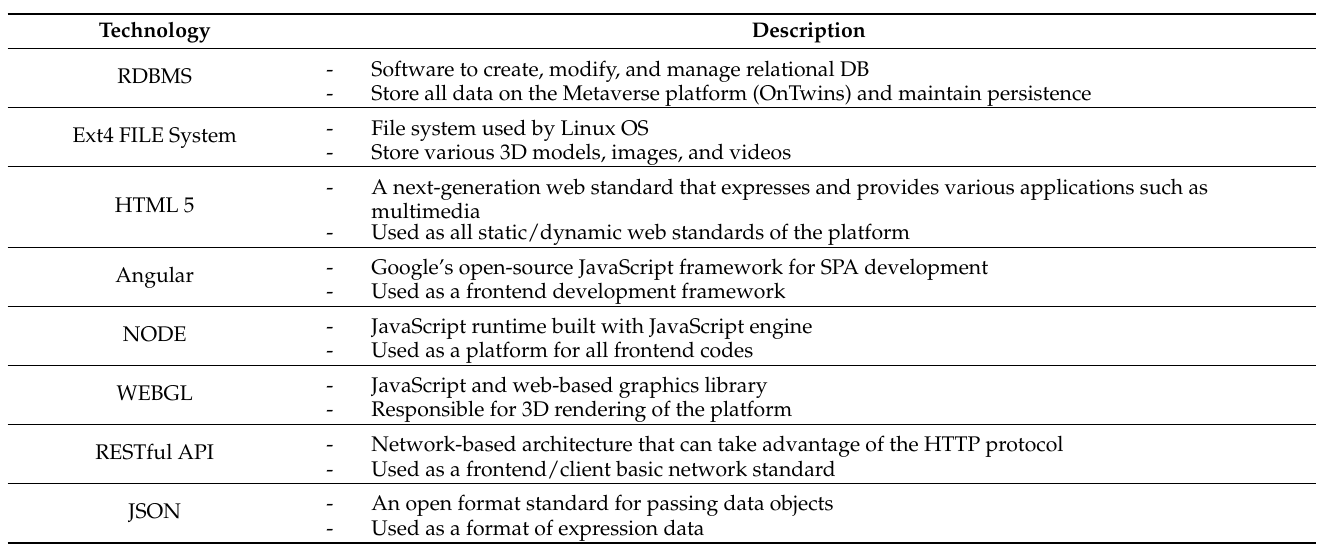
Figure 1. System Architecture. Table 1. Standard Technologies.